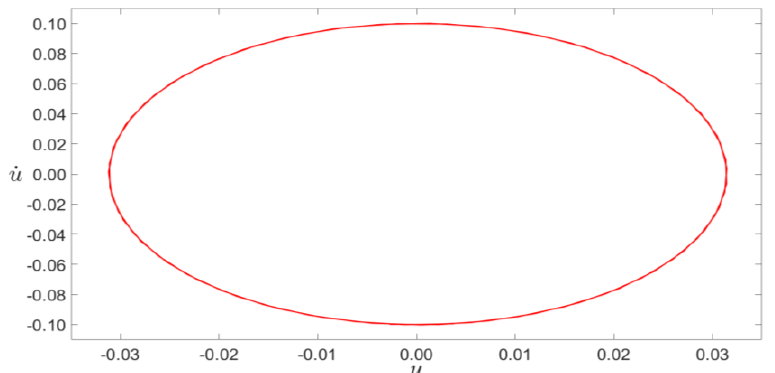
Figure 5. The phase portraits of primary resonant excitation for V DC = 1.5 V, V AC = 0.08 V, and